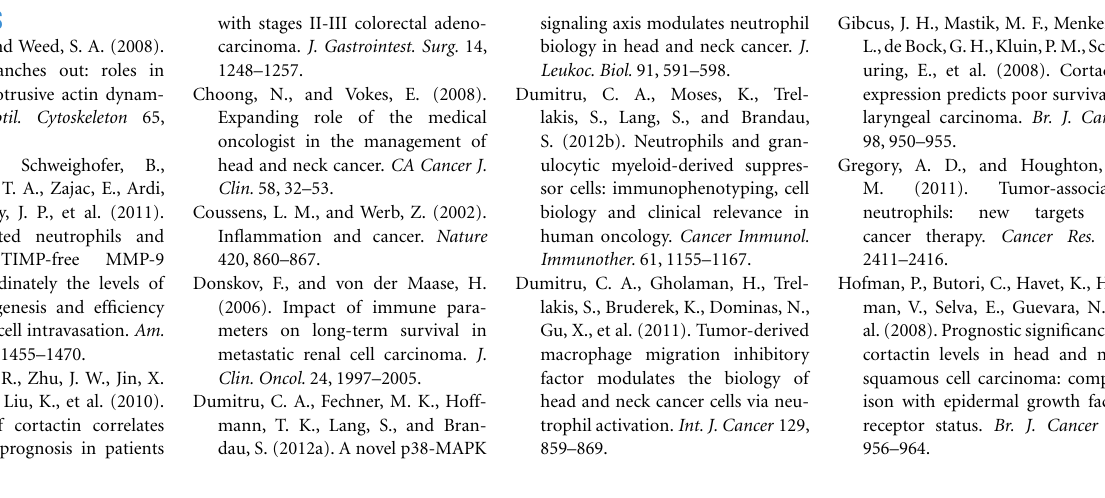
FIGURE 7 | Neutrophils promote the migration of FaDu cells via CORTACTIN. (A) FaDu cells in which CORTACTIN had been knocked-down by siRNA were stimulated with FaDu/neutrophil SN and migration was assessed 48h later. (B) Efficiency of CORTACTIN knock-down was determined by flow cytometric analysis of total CORTACTIN levels at 72h post-transfection. (C) FaDu cells (transfected with CORTACTIN or mock siRNA) were grown to confluency in the presence of “gap”-forming culture inserts.The “gap” refers